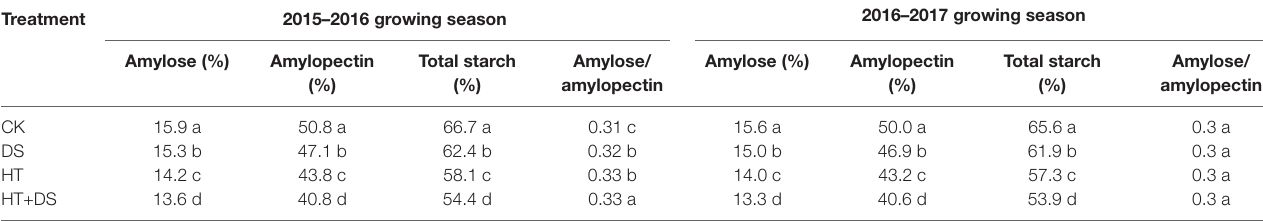
TABlE 1 | Total starch, amylose, and amylopectin contents in mature wheat grains for the three stress treatments. Treatment